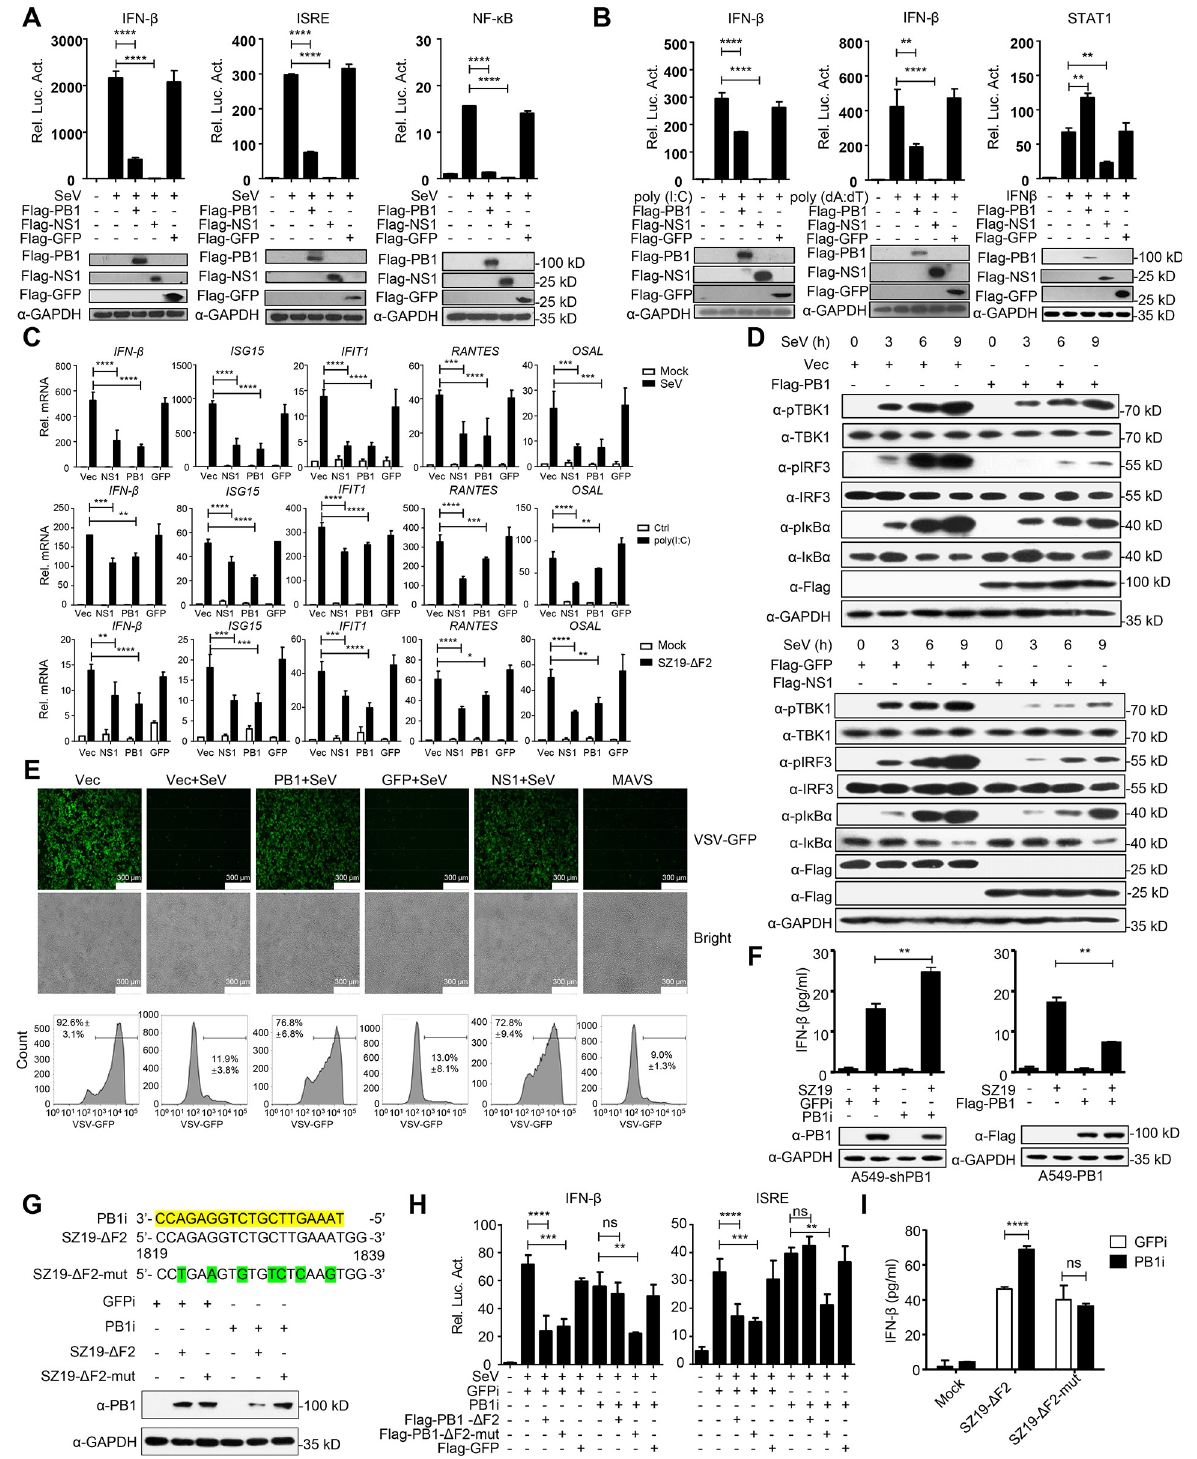
Fig 1. H7N9 PB1 negatively regulates type I IFN signaling pathway. (A) PB1 inhibits SeV-triggered activation of IFN- β promoter, ISRE and NF- κ B. HEK293 cells were transfected with IFN- β promoter, ISRE and NF- κ B luciferase reporter and the indicated plasmids (Flag-NS1 and Flag-GFP were chosen as positive and negative controls, respectively, throughout the study). Twenty hours after transfection, cells were left uninfected or infected with SeV for 12 h before reporter assays. (B) PB1 specifically inhibits cytosolic poly(I:C)- and poly(dA-dT)-triggered activation of IFN- β promoter. HEK293 cells were transfected with the IFN- β promoter or STAT1 luciferase reporter and the indicated plasmids. Twenty hours after